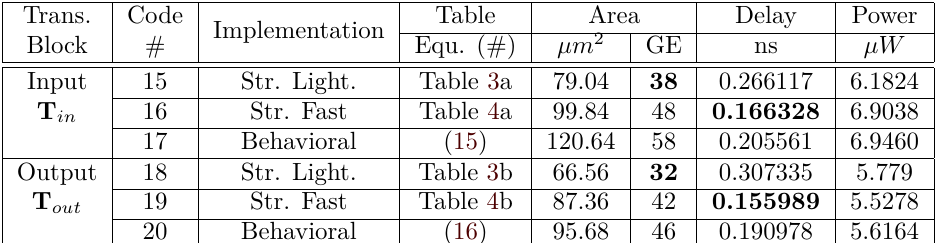
Table 8: ASIC synthesis results for the input and transformation matrix blocks. Trans.